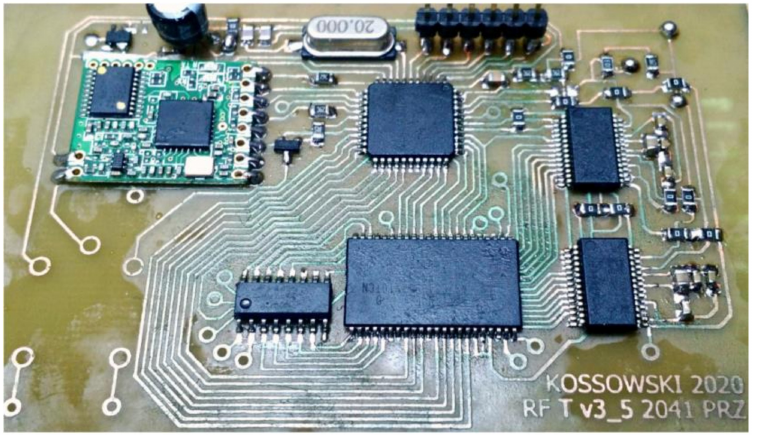
Figure 3. Photography of